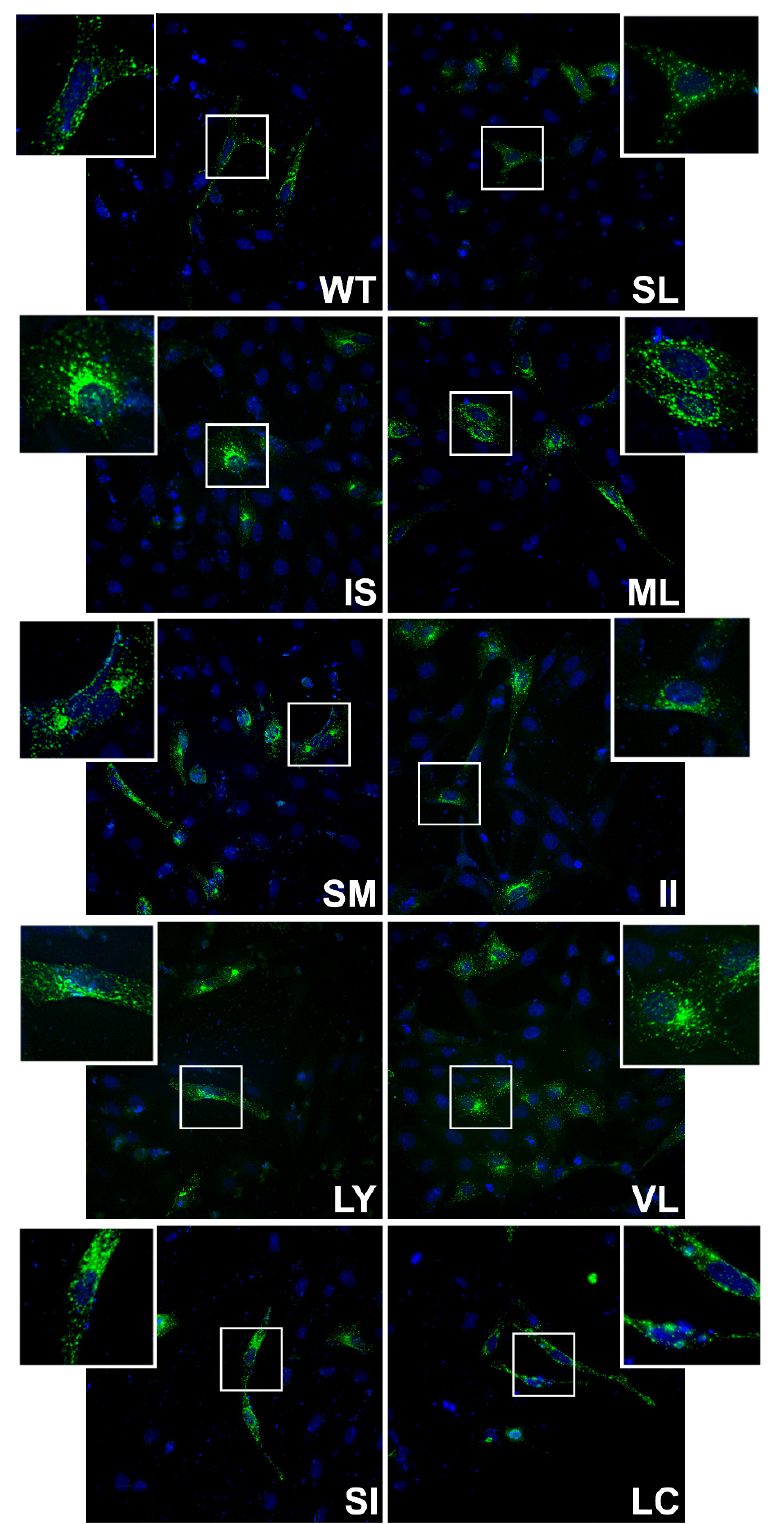
Figure 2. HeV F TM mutants have a similar distribution to WT F in immunofluorescence. Immunofluorescence of WT HeV F or each of the mutants created (Green is F, Blue is DAPI) transiently expressed in Vero cells. Insets represent enlargements of the boxed areas. Pulse-chase analysis was utilized to examine WT F or mutant protein cleavage kinet- ics and protein stability (Figure 3a). Most TM mutants displayed no change in protein